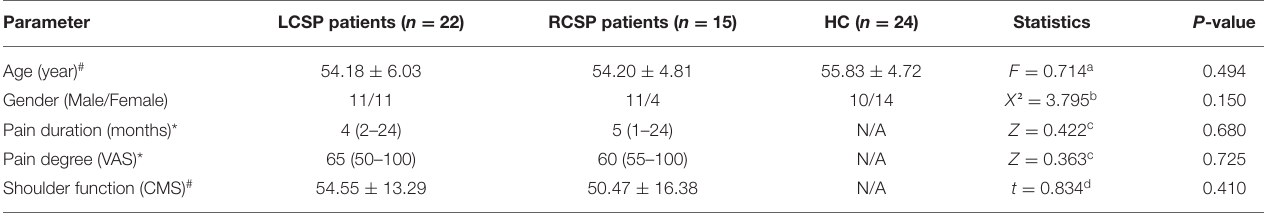
TABLE 1 | Demographic and clinical characteristics of patients with chronic shoulder pain (CSP) and healthy control